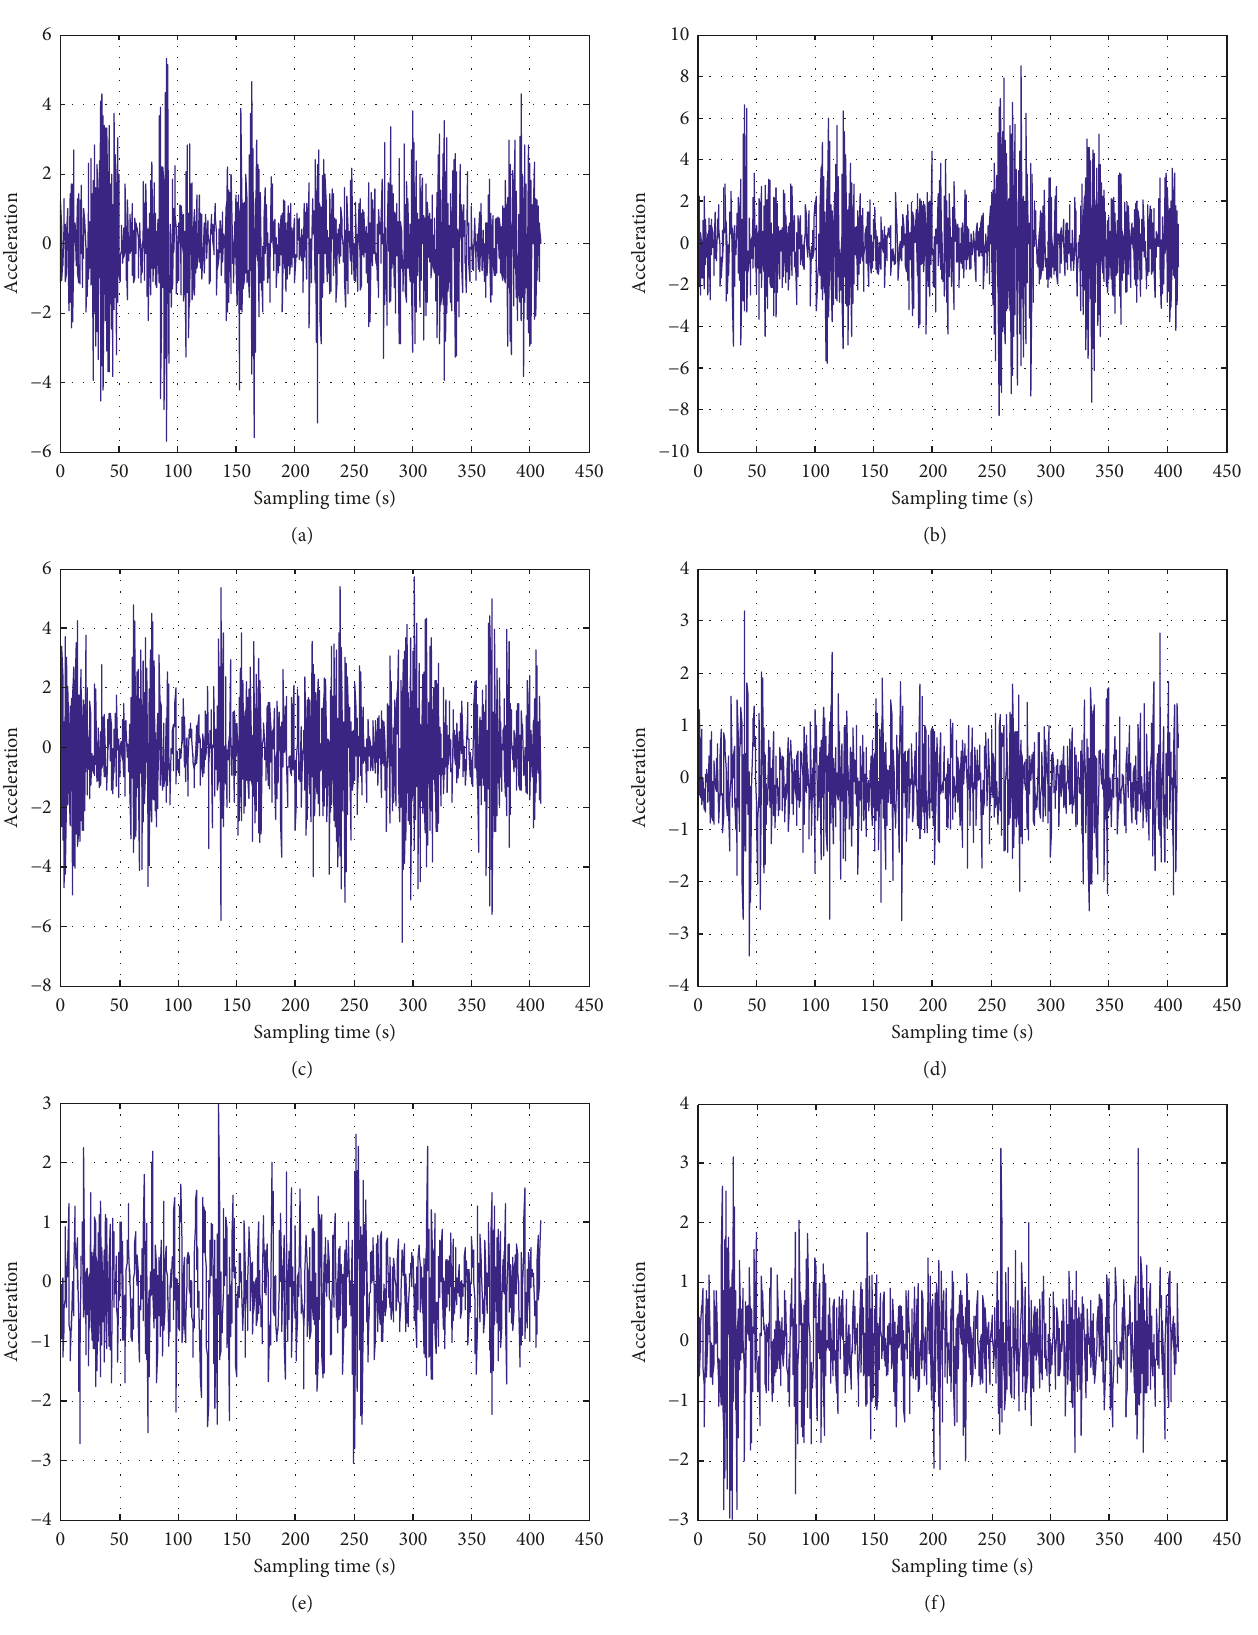
Figure 5: Vibration time-domain curves of the composite fault states: (a) gear teeth missing and bearing outer ring; (b) gear teeth missing and bearing inner ring wear; (c) gear teeth missing and bearing lack of ball bearings; (d) large and small gear teeth missing; (e) large and small gear teeth missing and bearing outer ring wear; (f) large and small gear teeth missing and bearing inner ring